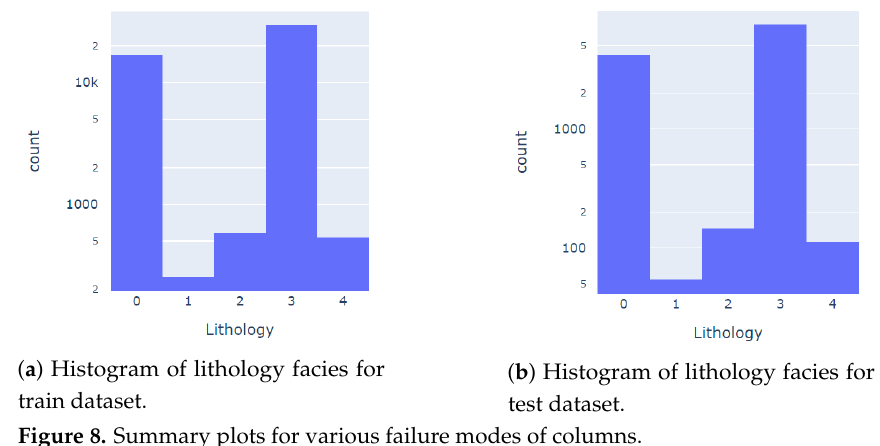
Figure 8. Summary plots for various failure modes of columns.